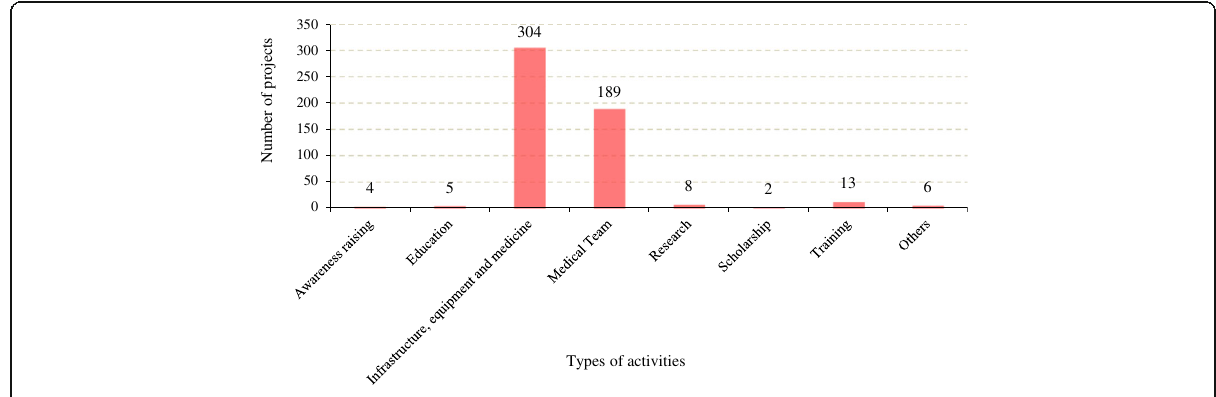
Fig. 4 Distribution of Chinese public health assistance by types of activities during 2000 –